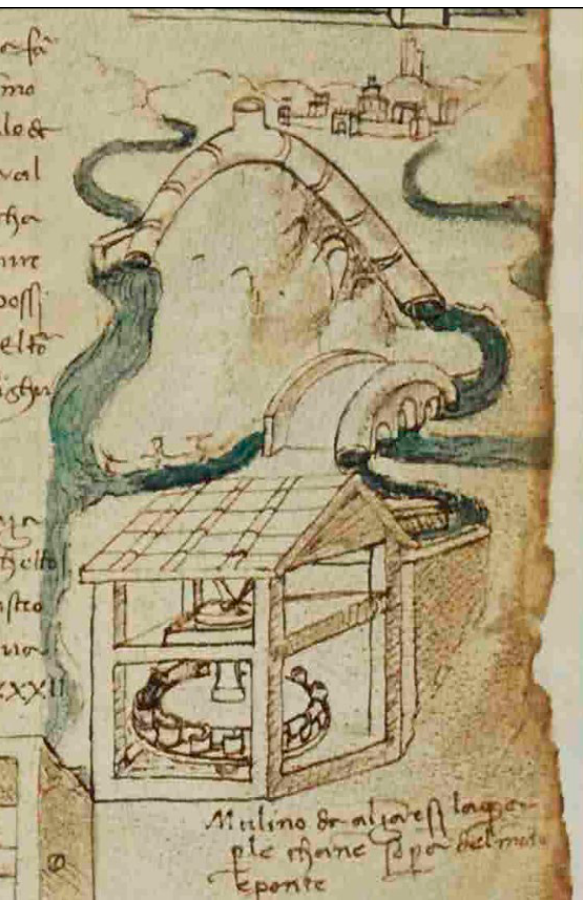
Figure 20. Francesco di Giorgio Martini, Trattati di architettura, ingegneria e arte militare , Firenze, Biblioteca Medicea Laurenziana, Cod. Ashb. 361, c. 38r, detail: bridge with siphon to carry the water of a canal from one bank to the other of a river.